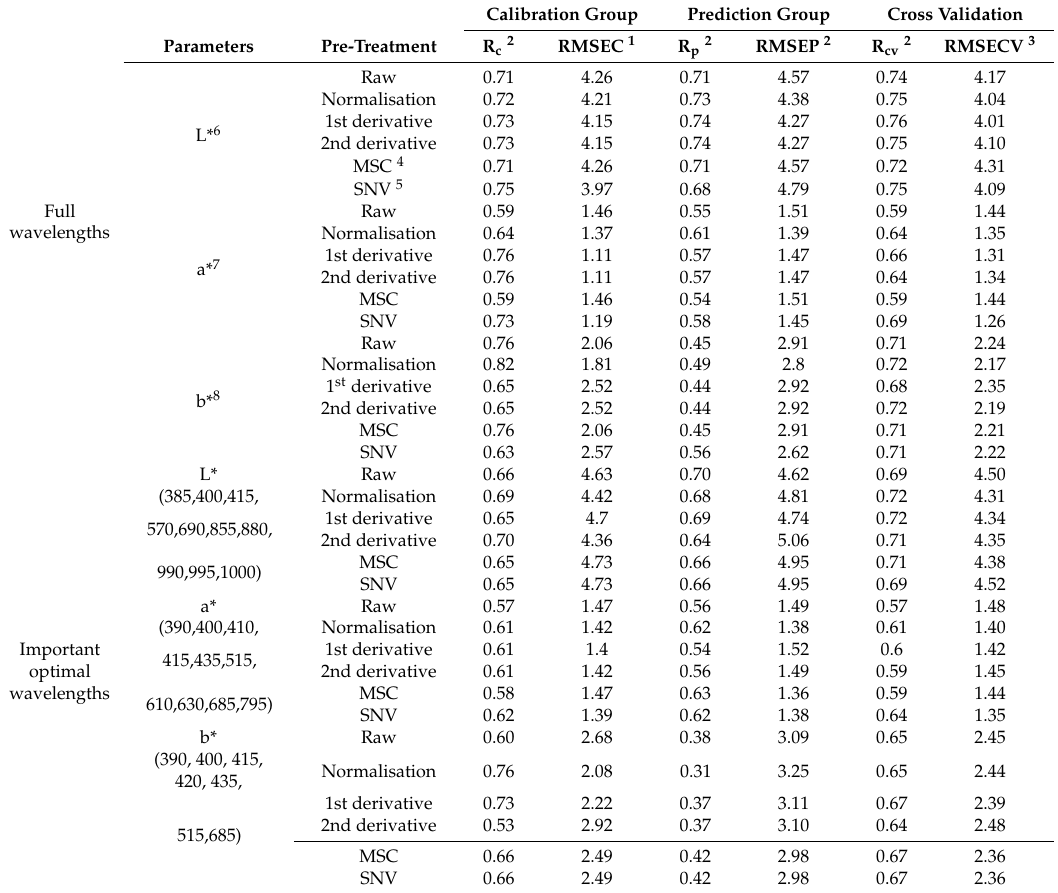
Table 2. Calibration and prediction statistics for predicting core colour parameters based on full and important optimal wavelengths using PLSR with di ff erent